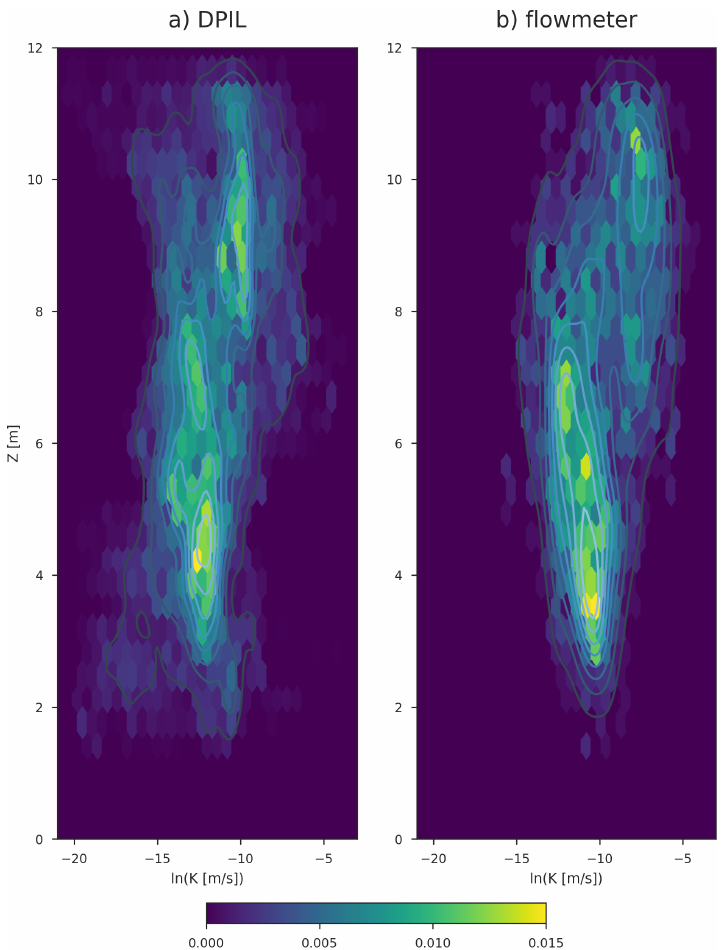
Figure 3. Bivariate histograms of elevation Z vs. ln ( K ) for the DPIL data-set (panel ( a )) and the flowmeter data-set (panel ( b )). Elevation given in meters above datum; Datum is 14.1 m below